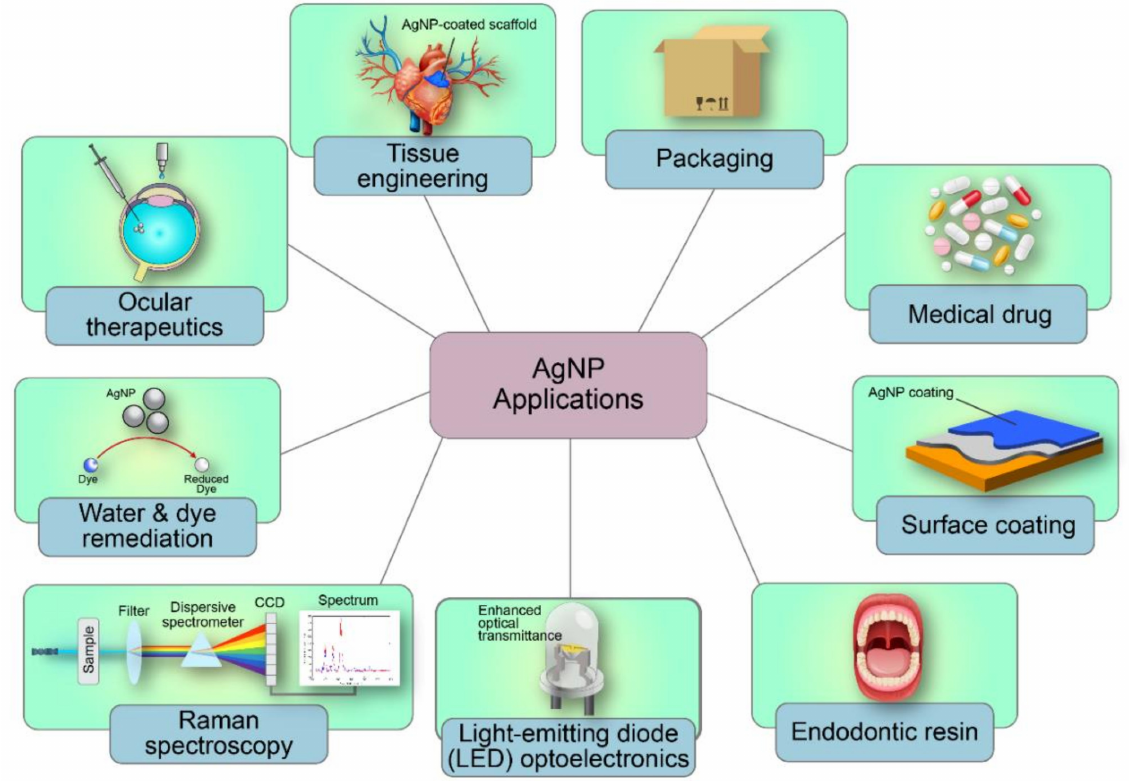
Figure 7. The various applications of